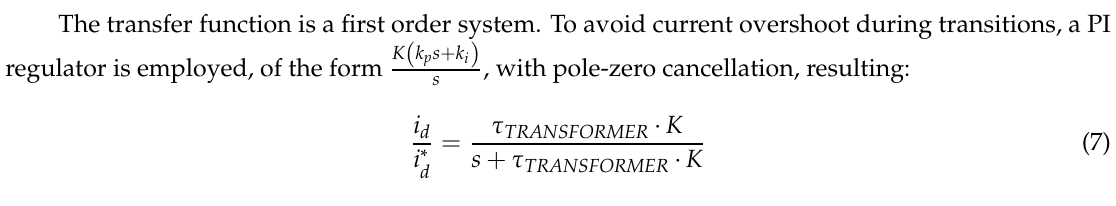
Figure 8. Closed loop current control.